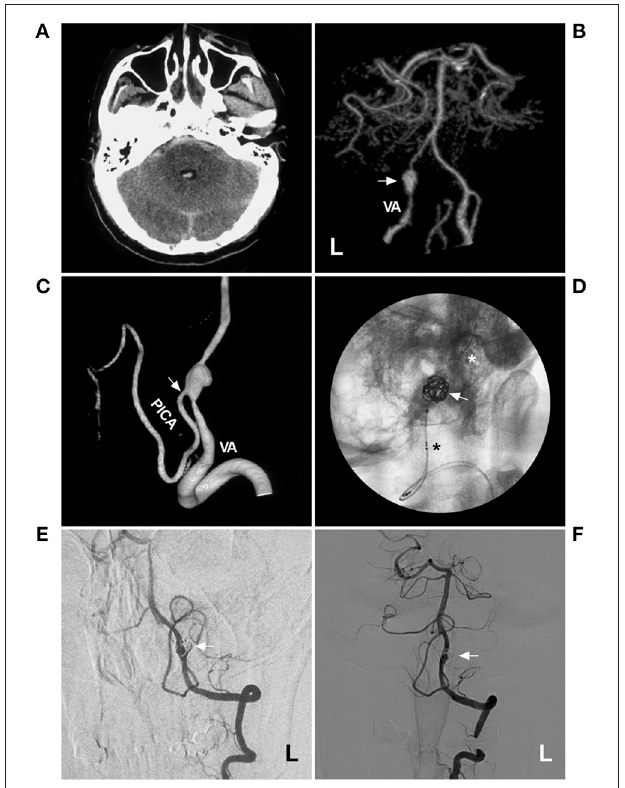
FIGURE 2 | Coiling a VA acute fusiform aneurysm with stent assistance. (A) CT showed subarachnoid hemorrhage and fourth intraventricular hemorrhage. (B) CTA showed a fusiform aneurysm (arrow) on the left VA. (C) Three-dimensional DSA showed the PICA (arrow) from the aneurysm. (D) X-ray film showed the LVIS (asterisks indicate the proximal and distal markers) to assist in coiling the aneurysm. (E,F) 1-year (E) and 2-year (F) follow-up DSA of the left VA showed no recurrence of the aneurysm. CT, computed tomography; CTA, computed tomography angiography; DSA, digital subtraction angiography; L, left; PICA, posterior inferior cerebellar artery; VA, vertebral artery.